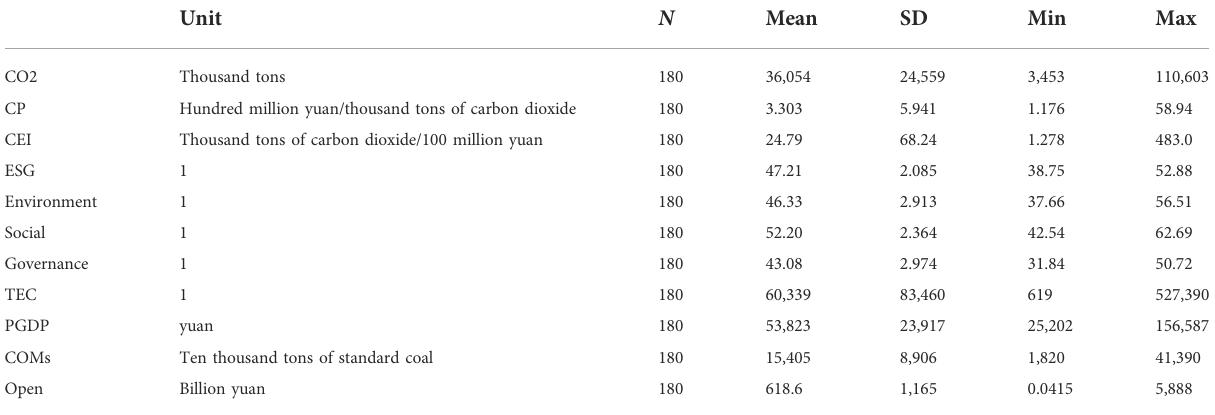
TABLE 2 Descriptive statistics.